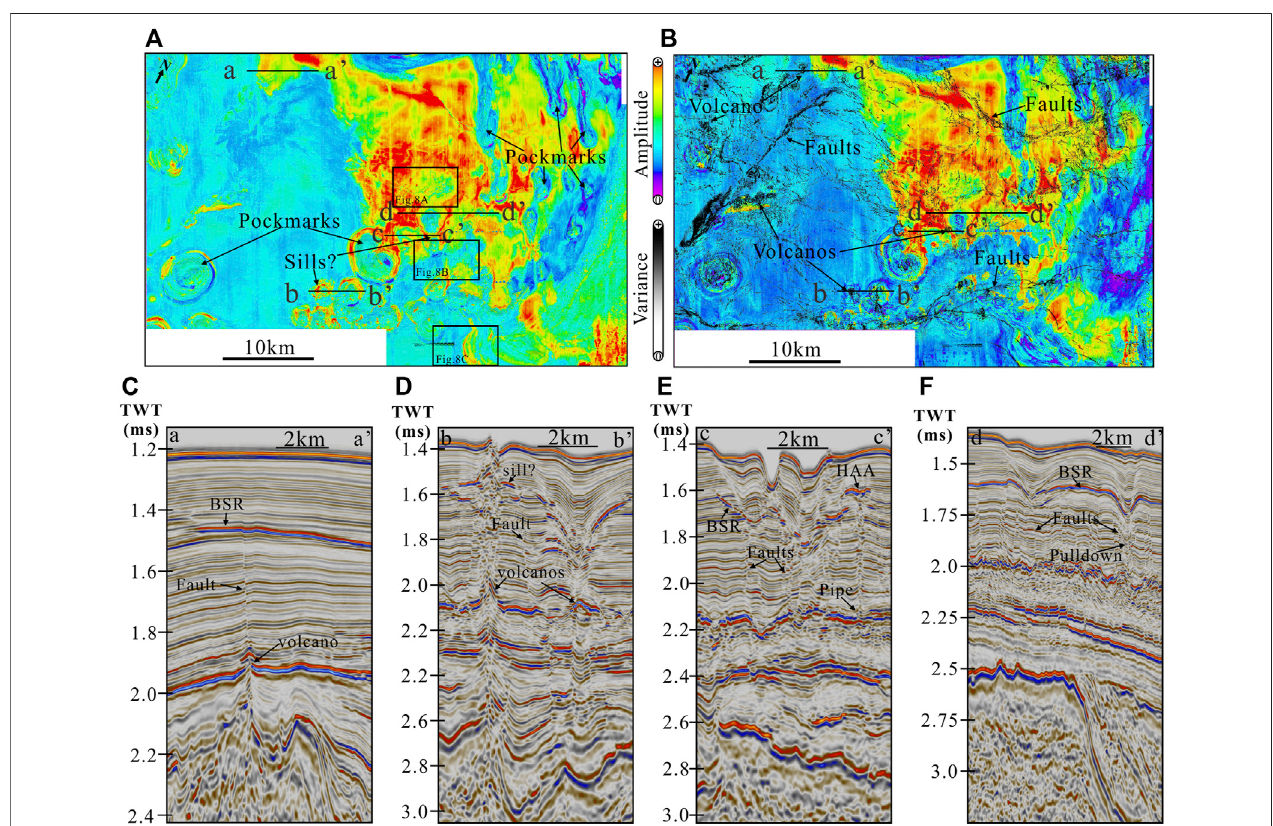
FIGURE10|(A) Maximum amplitude attribute maps extracted from horizon T1with atime window of50 ms showing variations ofamplitude. (B) Theoverlay map of maximum amplitude attribute extracted along horizon T1 within a time window of 50 ms and coherence slice along horizon T5, showing the distribution of the HAAs and deeper faults. (C – F) Showing seismic pro fi les of a-a ′ , b-b ′ , c-c ′ , and d-d ′ , respectively, and the seismic characteristics of BSR, faults, and volcanoes have been indicated at each section.